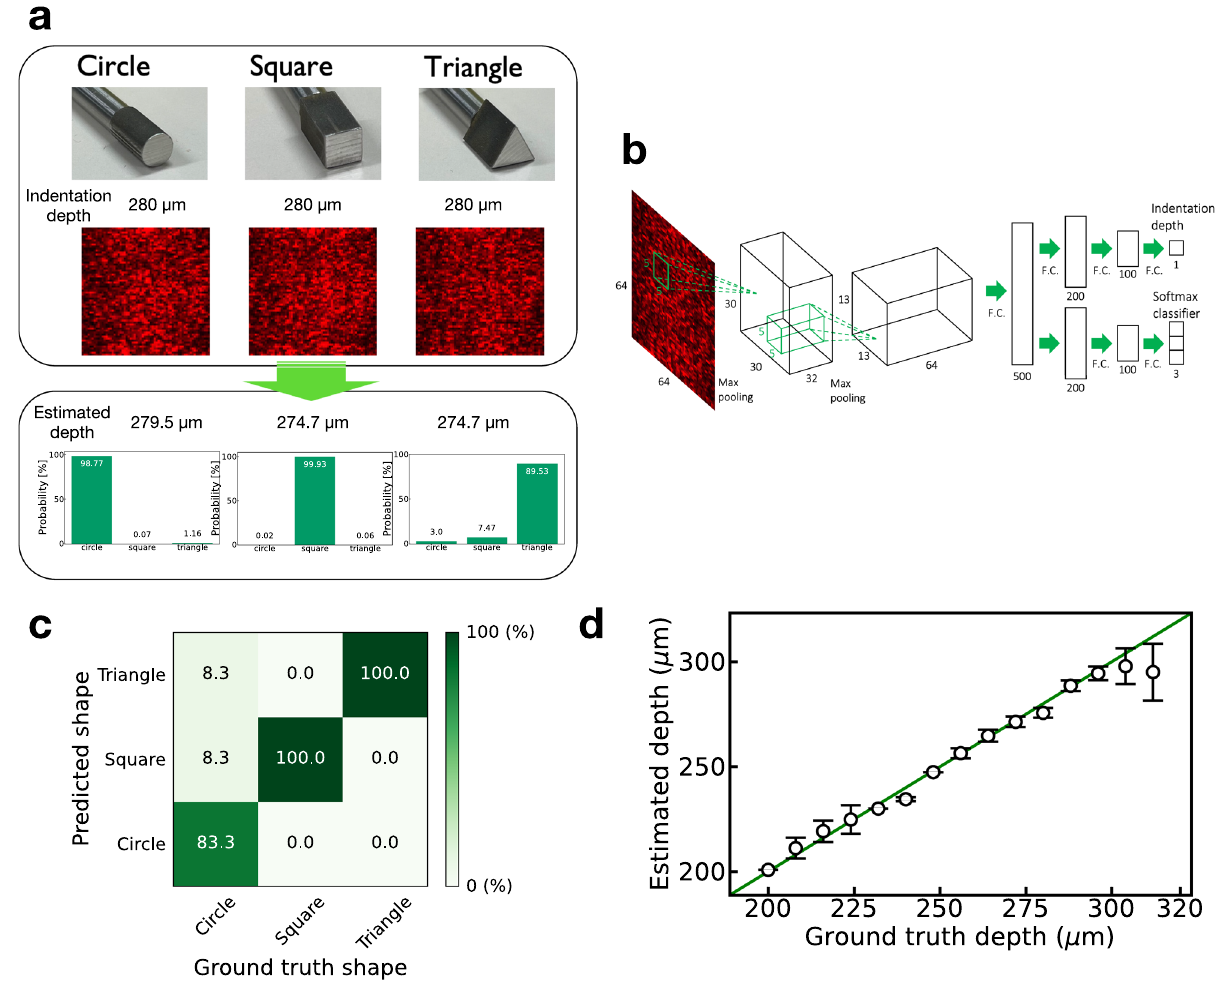
Figure 6. Simultaneous realization of sensing and perception. (a) Three indenters with circular, square, and triangular cross sections were used in the experiment. The speckle patterns change depending on the shapes of the indenters and contact force on the soft material. Examples of the speckle patterns for each indenter with an indentation depth of 280 µm are shown in (a) . The indenter shape and depth can be identified in the network model shown in (b) , where the common feature extractor is the same as that in the model shown in Fig. 2d. The network can be trained to reduce both the mean squared error and cross entropy with 405 training samples. The estimation results for 45 test samples are shown in (c) and (d) . (c) Confusion matrix of shape identification. (d) Estimation of the indentation